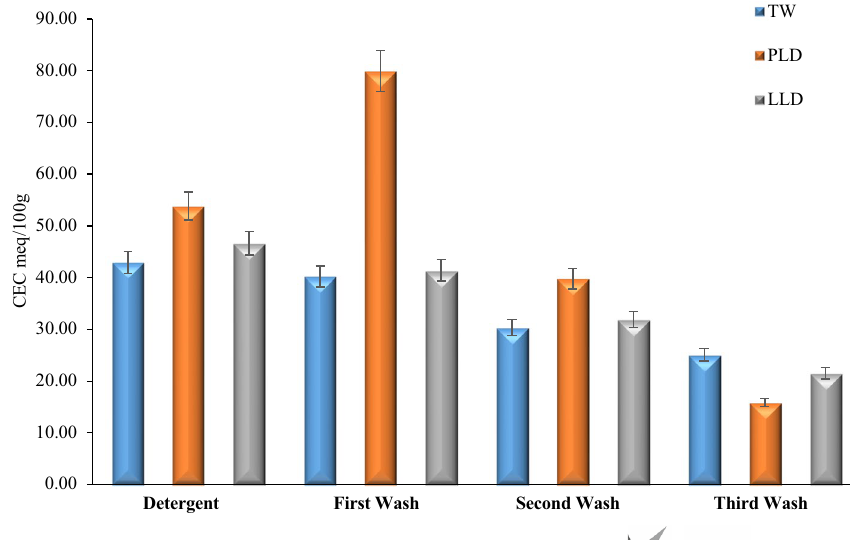
Fig. 3 Cation exchange capacity (CEC) of soil leachate after irrigated with tap water (TW), powder laundry detergent (PLD) and liquid laundry deter- gent (LLD)